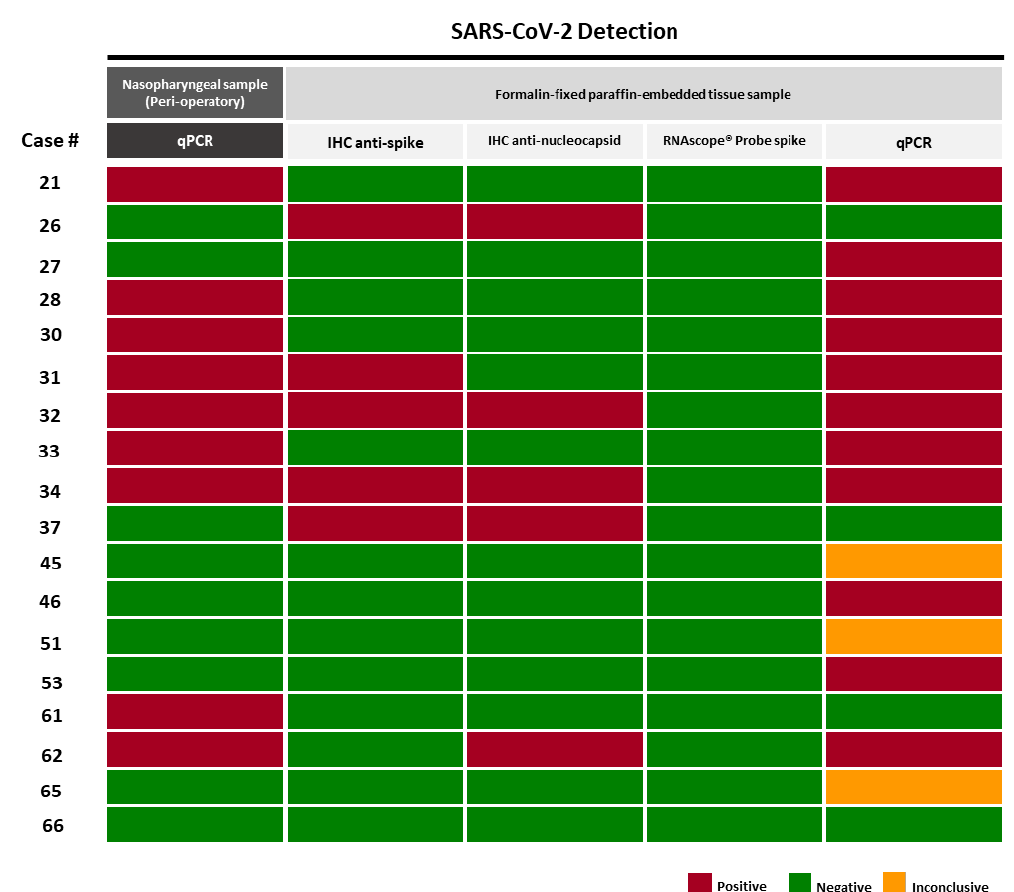
Figure 4. Comparison between SARS-CoV-2 detection by immunohistochemistry, in situ hybridiza- tion, and RT-qPCR in FFPE tumor tissues. Red—Positive cases; Green—Negative cases; Yellow— Inconclusive cases.